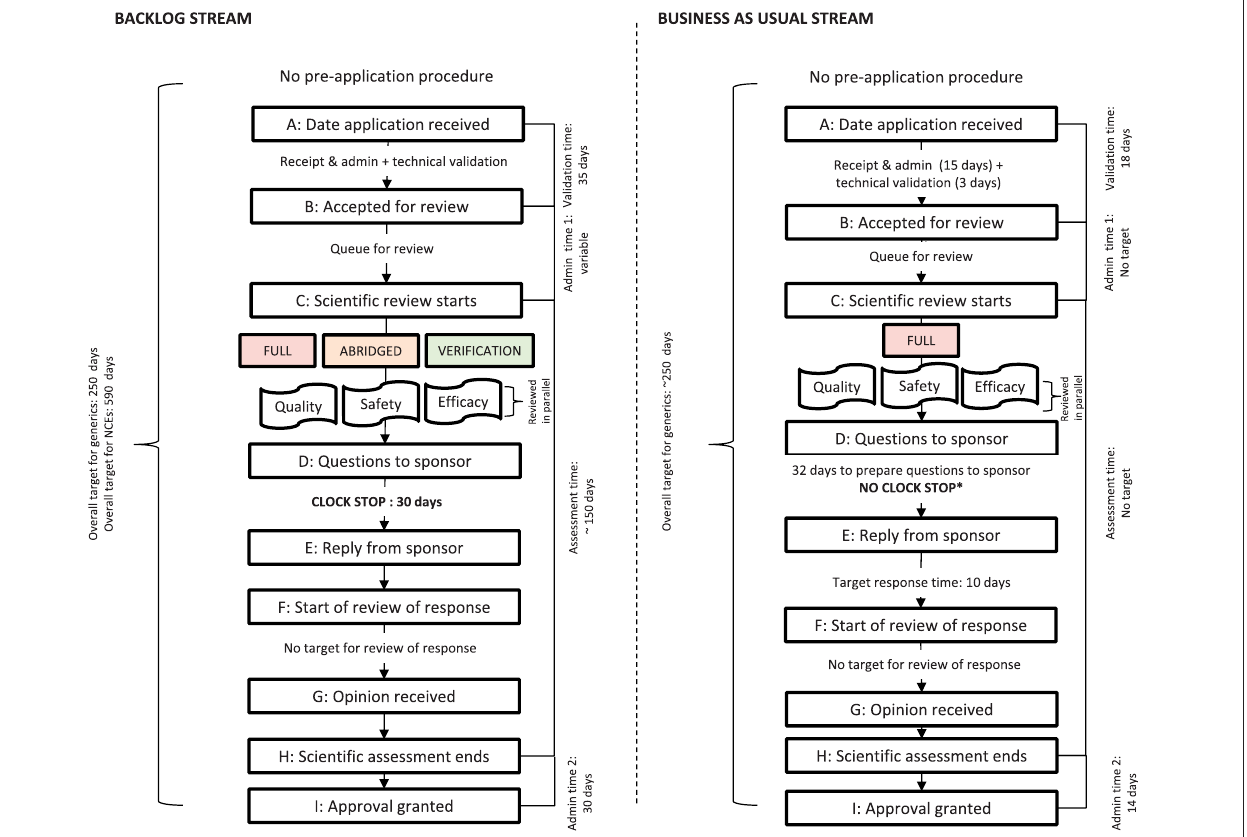
FIGURE 1 | Registration process map for the SAHPRA backlog (BL) stream and business-as-usual (BAU) stream. *No clock stop indicates that the sponsor ’ s response time is included in the overall review time